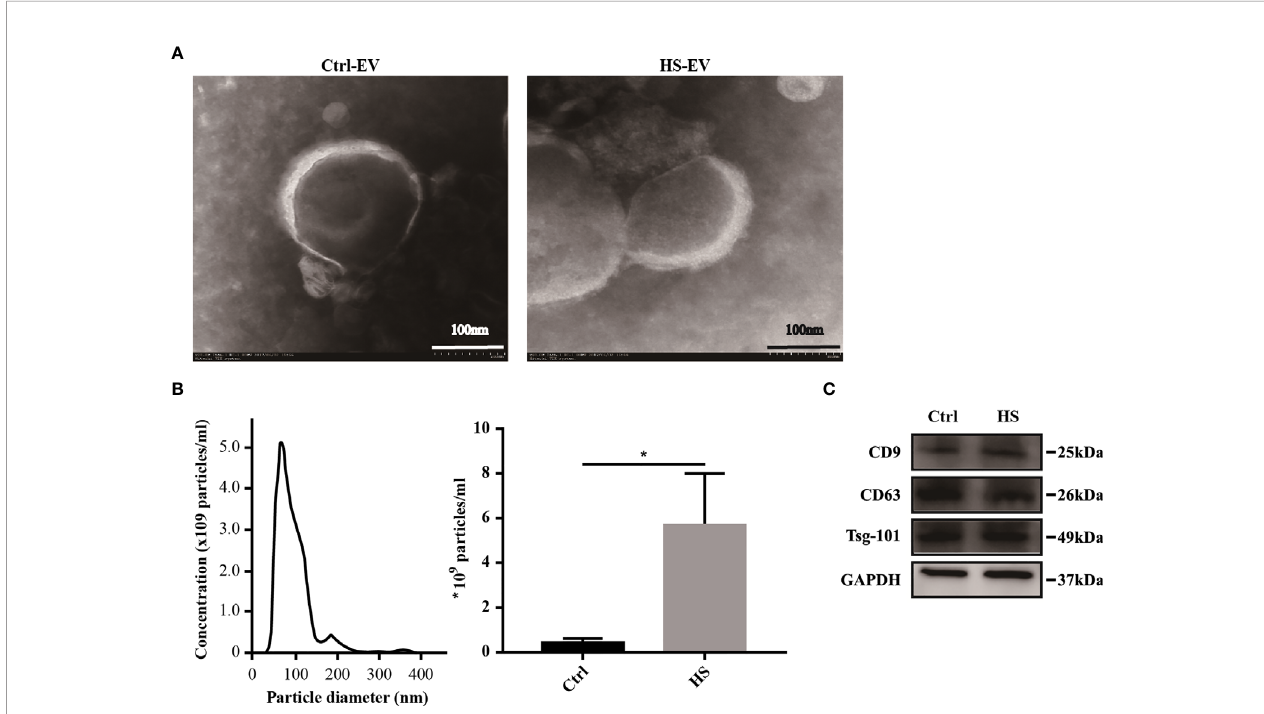
FIGURE 1 | Characterization of plasma exosomes in both healthy controls and HS patients. (A) Morphology of plasma exosomes visualized under TEM. Bar, 100 nm. (B) Exosome size distribution examined through NTA. (*) p < 0.05. (C) Levels of representative exosomal surface markers (CD9, CD63 along with Tsg-101) using western blot analysis. All experiments were repeated